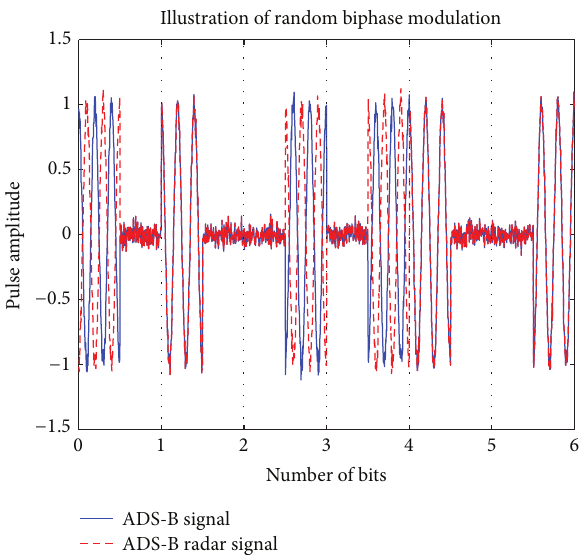
Figure 3: Illustration of the ADS-B waveform (blue) versus the ADS-B radar waveform (red).